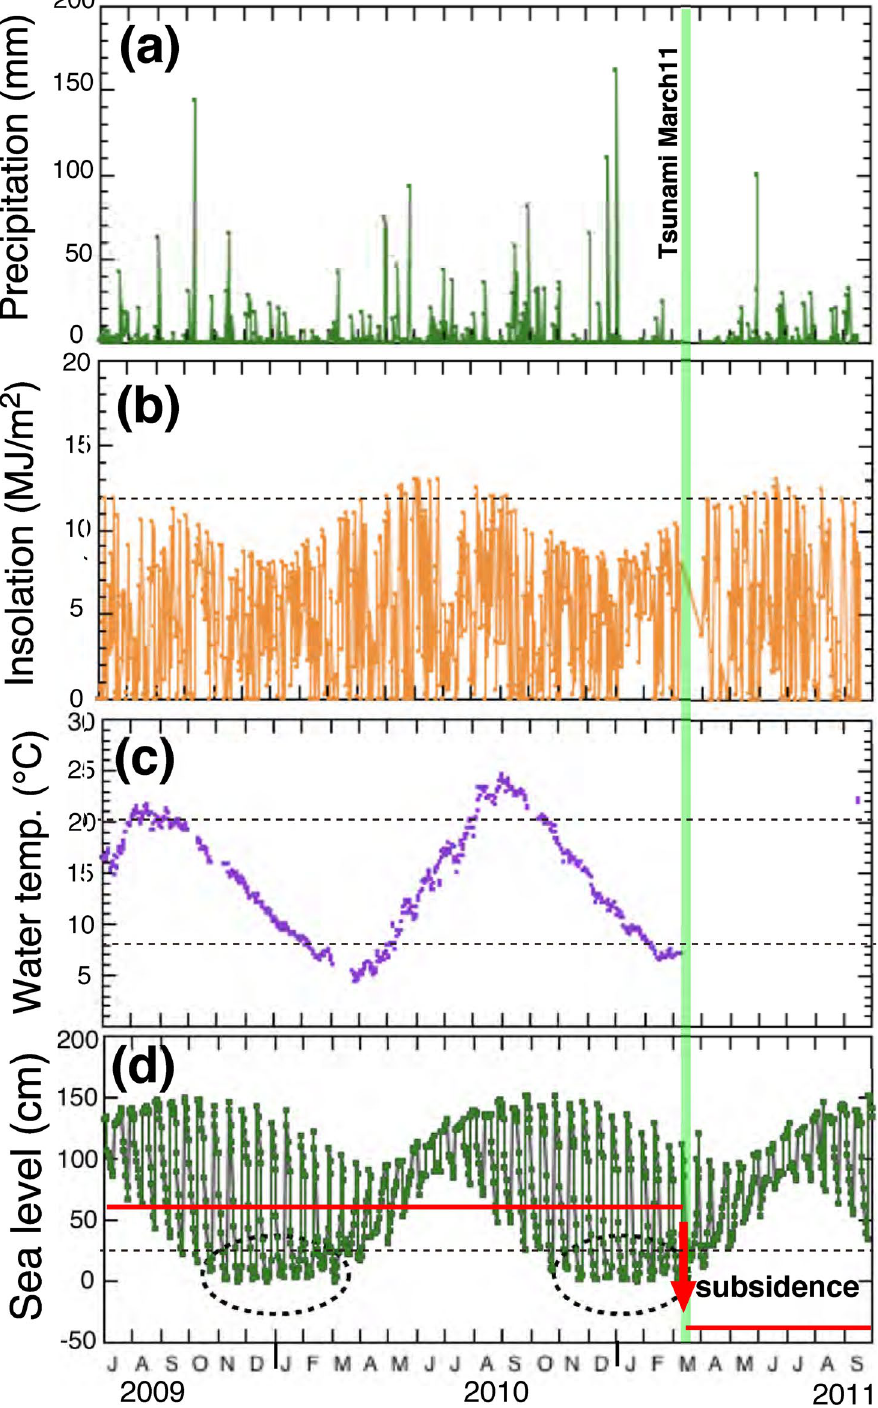
Figure 7. Environmental data from June 2009 to September 2011 in the studied region. ( a ) A record of daily precipitation in Miyako Bay, located 40 km north of the sampling site. ( b ) A record of daily insolation in Morioka city, 75 km northwest of the sampling site. A dashed line shows an arbitrary threshold value (12 MJ/ m 2 ). ( c ) A record of daily surface seawater temperature measured in the sampling site of Otsuchi Bay. Dashed lines show arbitrary threshold values (20 °C and 8 °C). ( d ) A record of daily sea level change calculated by astronomical data in Kamaishi Bay, 9 km south of the sampling site. Ovals show the low tide during the period. The profiled was descrived by using a soft ware “TIDE for WIN” (http:// fmie. cside7. com/ progr am/ tide. html). A dashed line shows an arbitrary threshold value (25